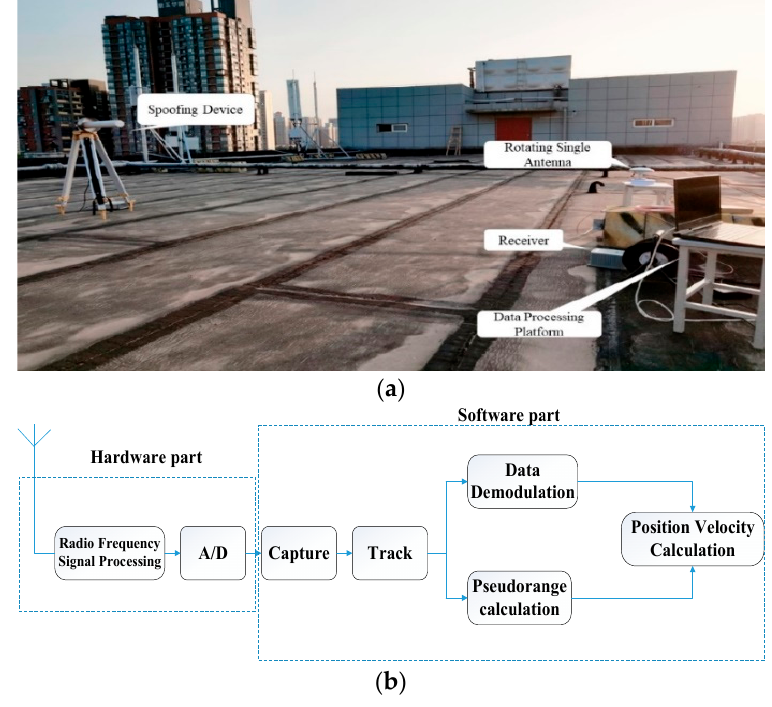
Figure 5. Experimental scene settings. ( a ) Rooftop experimental scene settings; ( b ) The working principle of the receivers.